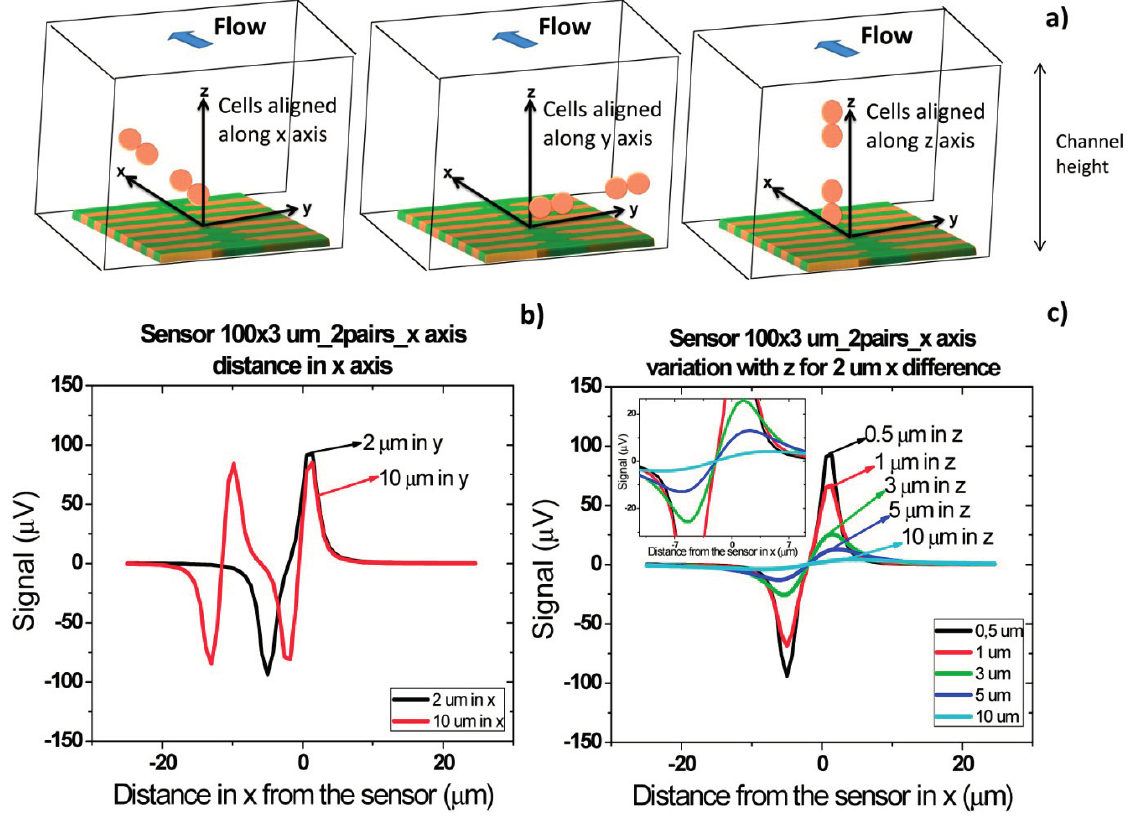
Figure 16. Signal simulation for two Streptococcus agalactiae along x axis. ( a ) Schematics of cell pair’s orientation considered for simulation; ( b ) Cells at a given distance along x axis; ( c ) Signal variation with height from the sensor for cells at 10 μ m distance from each other along x